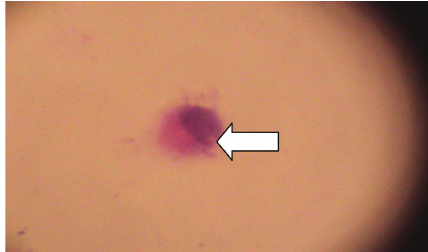
Figure 4: (100x) CSF cytology showing large cells with high nuclear to cytoplasmic ratio. Malignant cell shown by arrow.